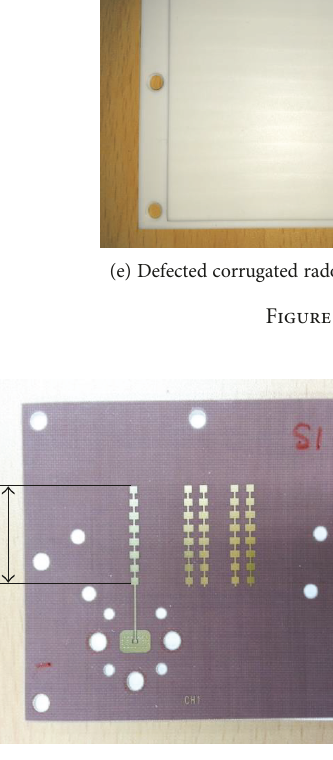
Figure 18: Photograph of a fabricated fi ve-channel series-fed patch array.